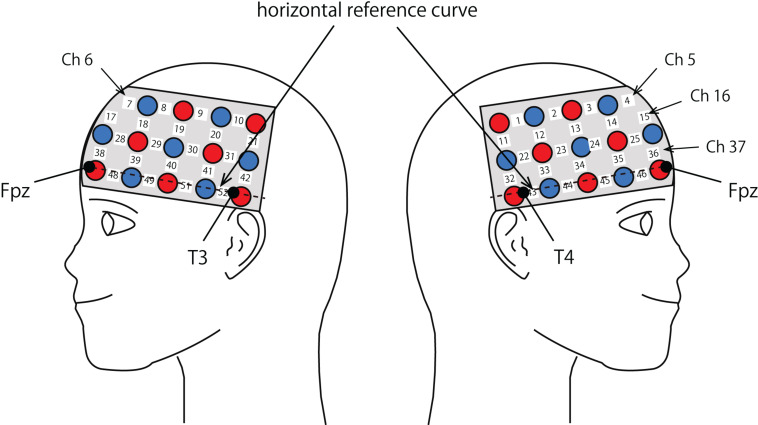
Spatial profiles of fNIRS channels. Left and right sides views of the probe arrangements are exhibited with fNIRS channel orientation. Detectors are indicated with blue circles, illuminators with red circles, and channels with white squares. Corresponding channel numbers are shown in black. Chs 5, 6, 16, and 37 are not visible, but located around or over the midline.